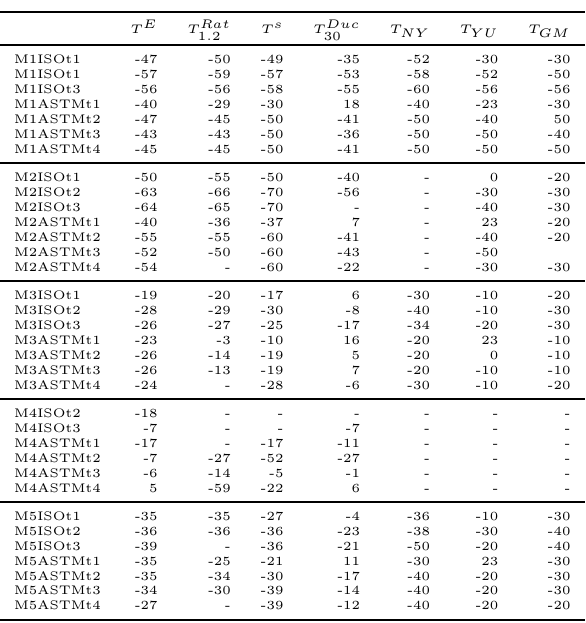
Table 3. Overview of all transition temperatures (all values in Celsius); nomenclature e.g. M3ISOt1: material M3, ISO test standard and 1 mm thick speci- mens.